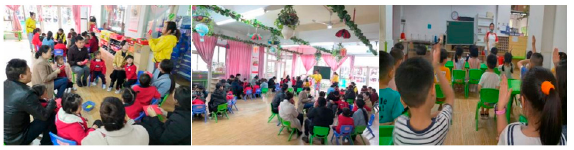
Figure A4. Parents participate in activities to observe children’s performance.